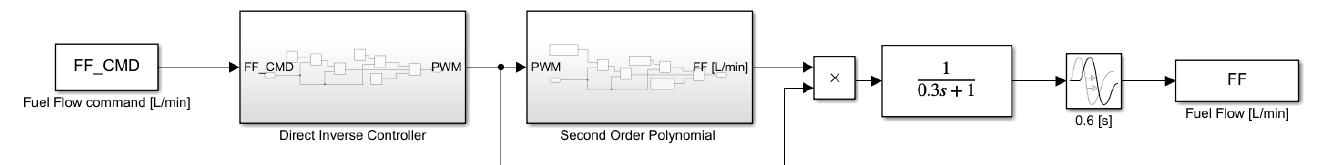
Figure 6. Implementation of the direct inverse controller in simulation environment.